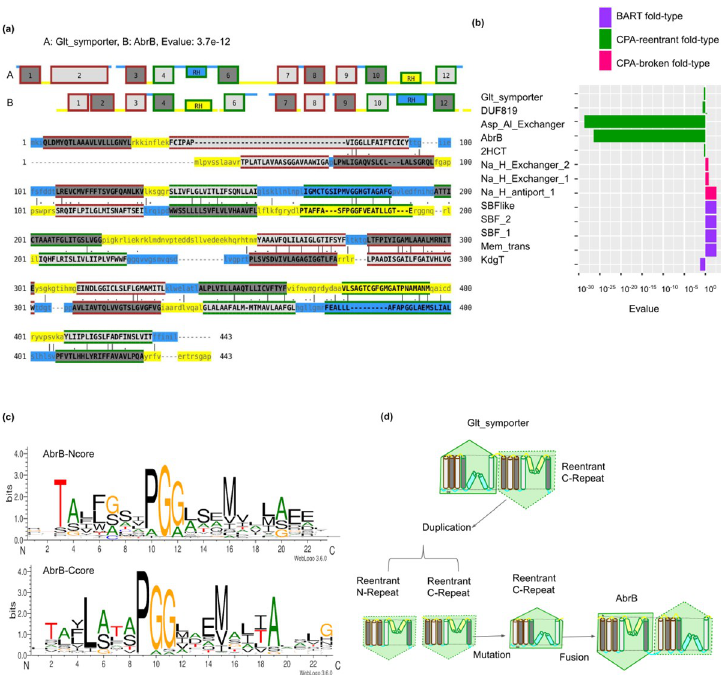
Fig 6. Change in orientation in reentrant transporters by internal duplications. (a) Sequence and topology alignment between transporters from CPA-reentrant fold-type showing the change in orientation. All the transmembrane helices are numbered sequentially and the reentrant helix is denoted as RH. (b) Sequence similarity between N- and C-terminal repeats represented by E-values in different families with fold-types containing symmetric repeat units are shown (c) Reentrant N- and C-terminal core helix motif (d) Cartoon representation showing the events of duplication from C-terminal repeat of reentrant transporter and subsequent internal duplication leading to change in